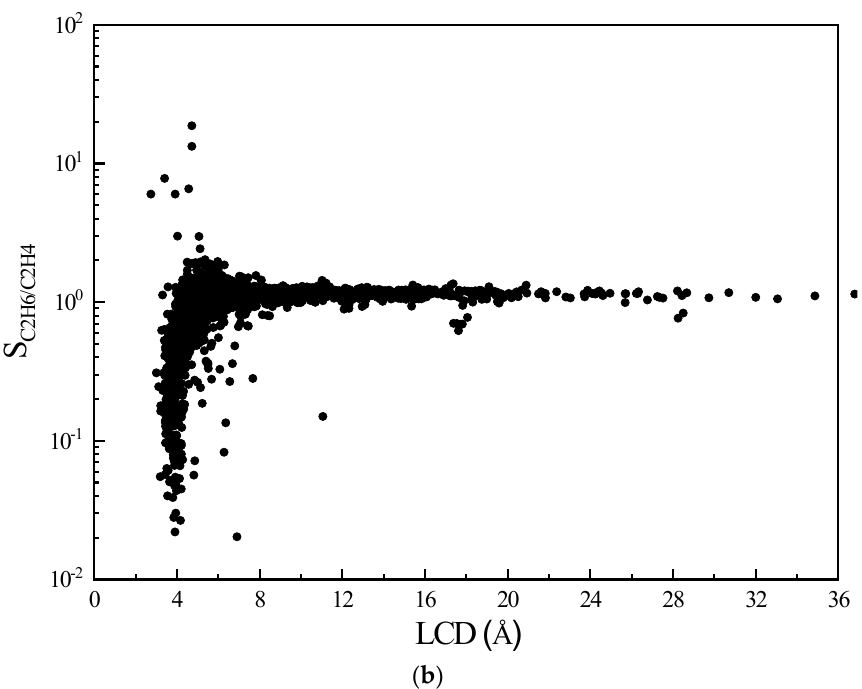
Figure 6. Adsorption selectivity of MOF with respect to ( a ) C 2 H 2 /C 2 H 4 and ( b ) C 2 H 6 /C 2 H 4 versus LCD.